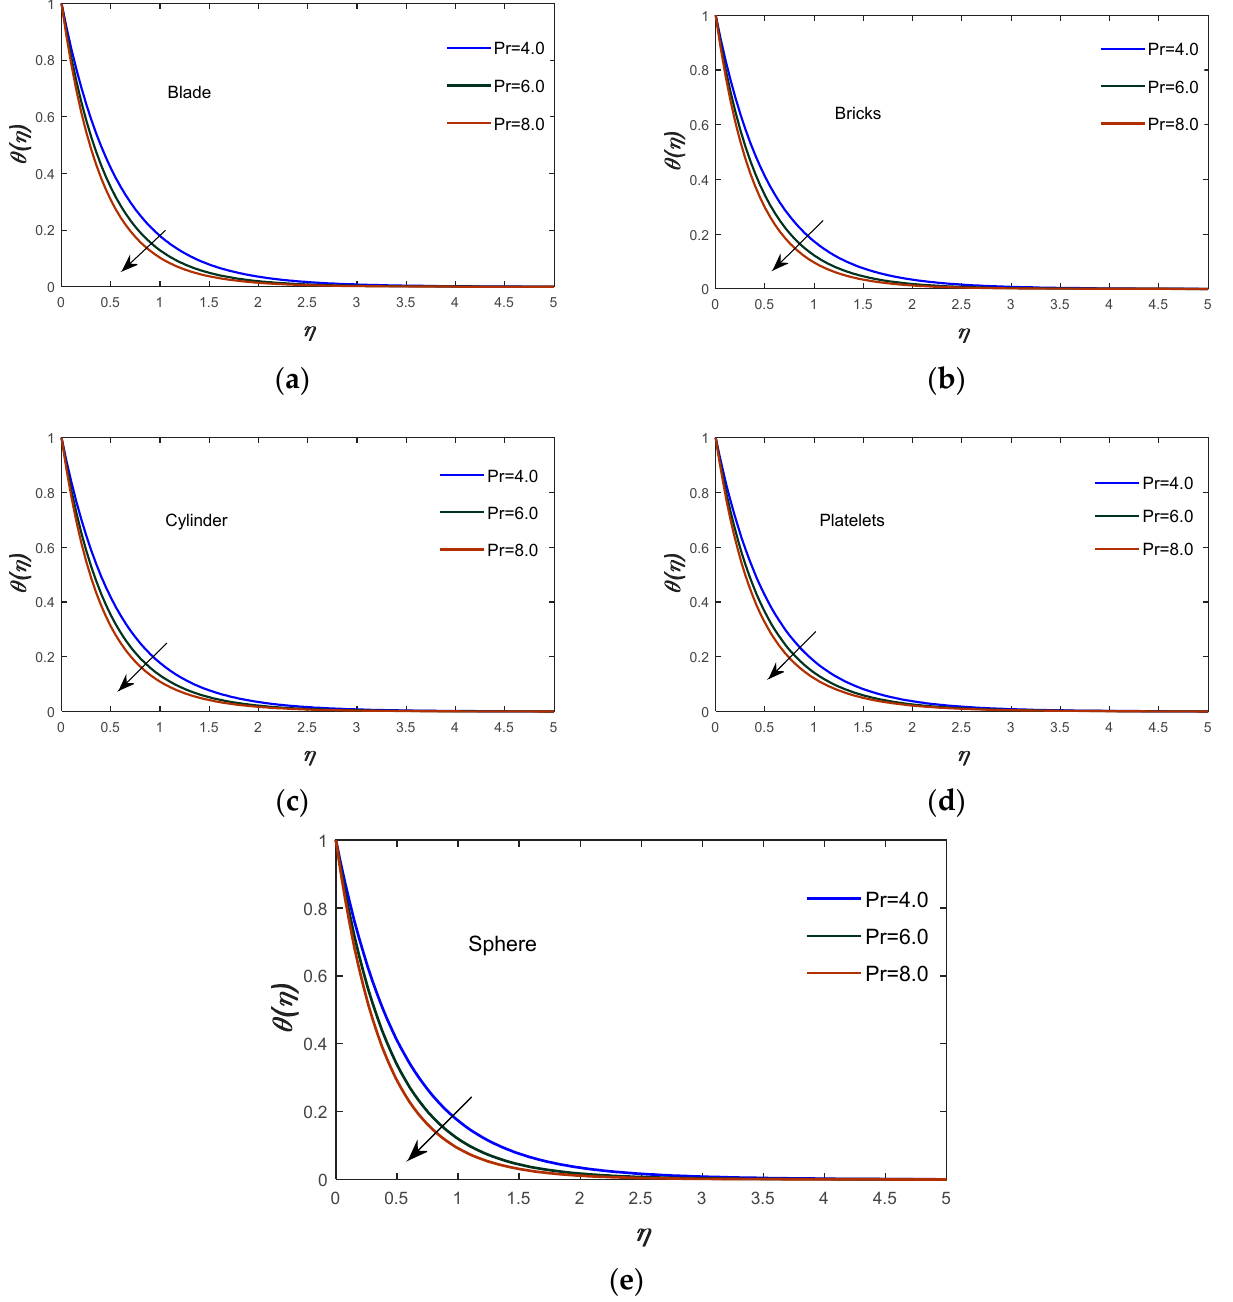
Figure 9. ( a – e ). Impact of Pr on θ ( η ) by using various shapes factors of nanoparticles for fixed M = 1.0, k = 0.5, S = 0.5, Ec = 1.0, ϕ = 0.02 .